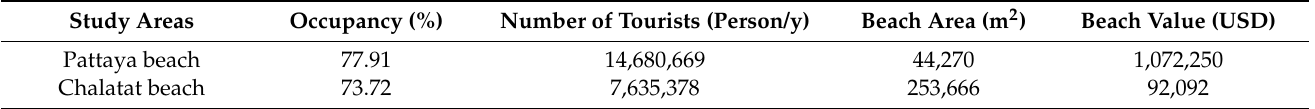
Table 10. Beach value.